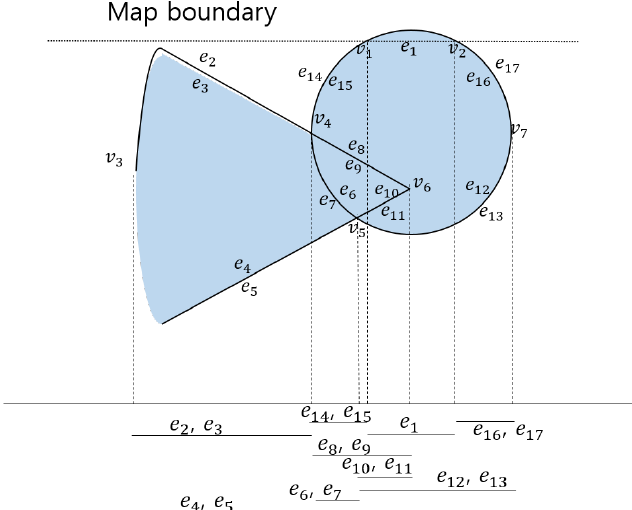
Figure 9. An example of segments to be stored in a segment